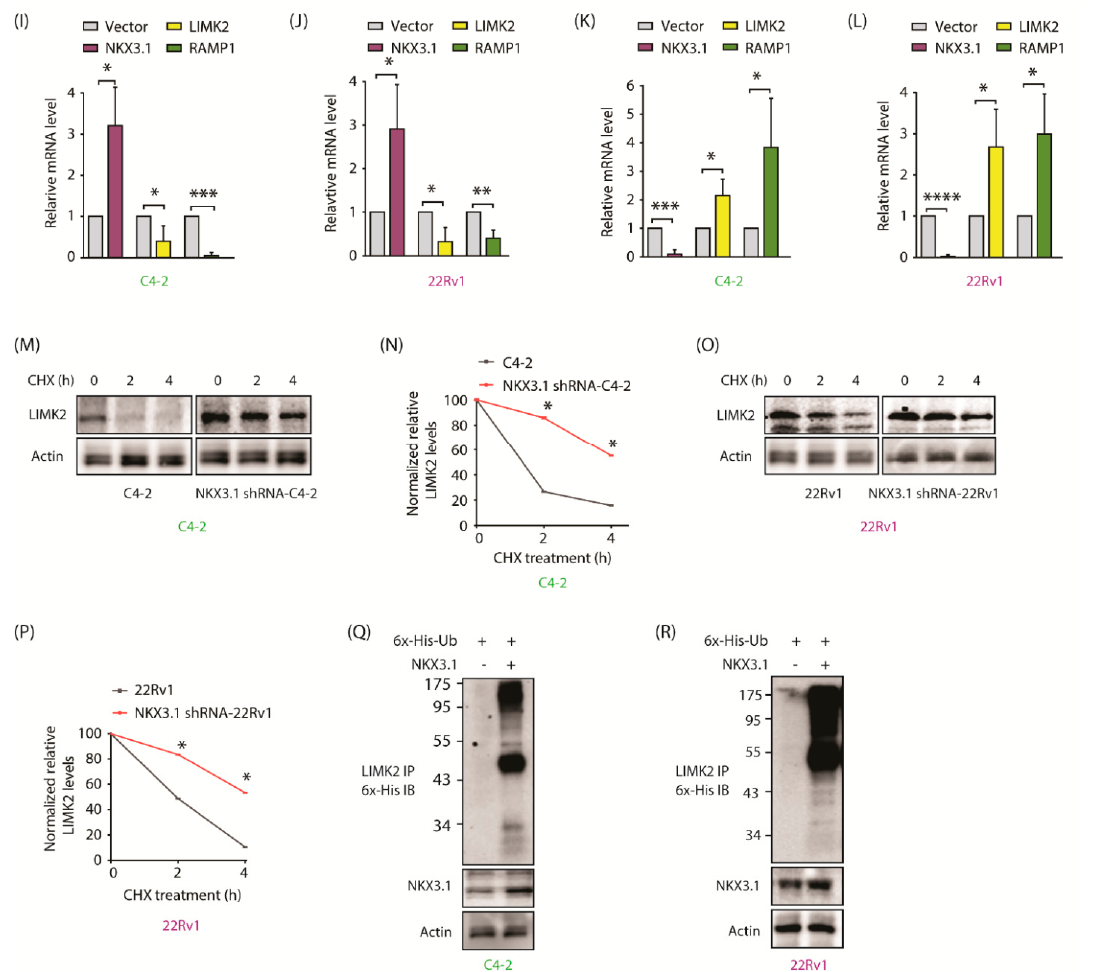
Figure 3. NKX3.1 negatively regulates LIMK2 mRNA levels and protein stability. ( A ) NKX3.1 overexpression results in LIMK2 protein downregulation. C4-2 cells were transiently infected using the either vector or NKX3.1 retrovirus; ( B ) The histogram represents a quantitative analysis of protein levels from three independent experiments. The protein levels are normalized to the actin. *** p < 0.001 and **** p < 0.0001; ( C ) NKX3.1 upregulation results in LIMK2 protein downregulation. 22Rv1 cells were infected with NKX3.1 retrovirus for 33 h; ( D ) The graph shows quantitative analysis of protein levels from three independent experiments. ** p < 0.01; ( E ) Downregulation of NKX3.1 increases LIMK2 protein level. C4-2 cells were transiently infected with NKX3.1 shRNA lentivirus; ( F ) The histogram shows quantitative analysis of LIMK2 and NKX3.1 protein levels in scrambled shRNA-treated and NKX3.1 shRNA-treated cells from three independent experiments. * p < 0.05, **** p < 0.0001; ( G ) Downregulation of NKX3.1 increases LIMK2 protein level in 22Rv1 cells; ( H ) Quantitative analysis of detected protein levels from three independent experiments. * p < 0.05; ( I ) Ectopic expression of NKX3.1 reduces LIMK2 mRNA level in C4-2 and ( J ) 22Rv1 cells. The target cells were infected with NKX3.1 retrovirus. Total RNA was extracted, and mRNA levels were quantified by qRT-PCR from three independent experiments. GAPDH was used as the control. * p < 0.05, ** p < 0.01, and *** p < 0.001; ( K ) Depletion of NKX3.1 increases LIMK2 mRNA level in C4-2 cells and ( L ) 22Rv1 cells. Data were obtained from three independent experiments using GAPDH as the control. * p < 0.05, *** p < 0.001, and **** p < 0.0001; ( M ) LIMK2 degradation in C4-2 cells upon NKX3.1 knockdown. The cells were treated by NKX3.1 shRNA lentivirus for 33 h, followed by CHX (20 µ g/mL) treatment for 2 and 4 h. Subsequently, the cells were lysed, and the LIMK2 protein level was analyzed; ( N ) The graph represents the statistical analysis from three independent experiments as described in ( M ). * p < 0.05; ( O ) LIMK2 degradation in 22Rv1 cells treated with NKX3.1 shRNA lentivirus and CHX. ( P ) The graph represents the statistical analysis from three independent experiments as treated in ( O ); * p < 0.05. ( Q ) NKX3.1 overexpression increases LIMK2 ubiquitylation in C4-2 and ( R ) 22Rv1 cells. Target cells expressing either vector or NKX3.1 were infected by 6x-His-ubiquitin retrovirus. Cells were treated with MG132 for 10 h. Ubiquitylation of LIMK2 was analyzed using 6x-His